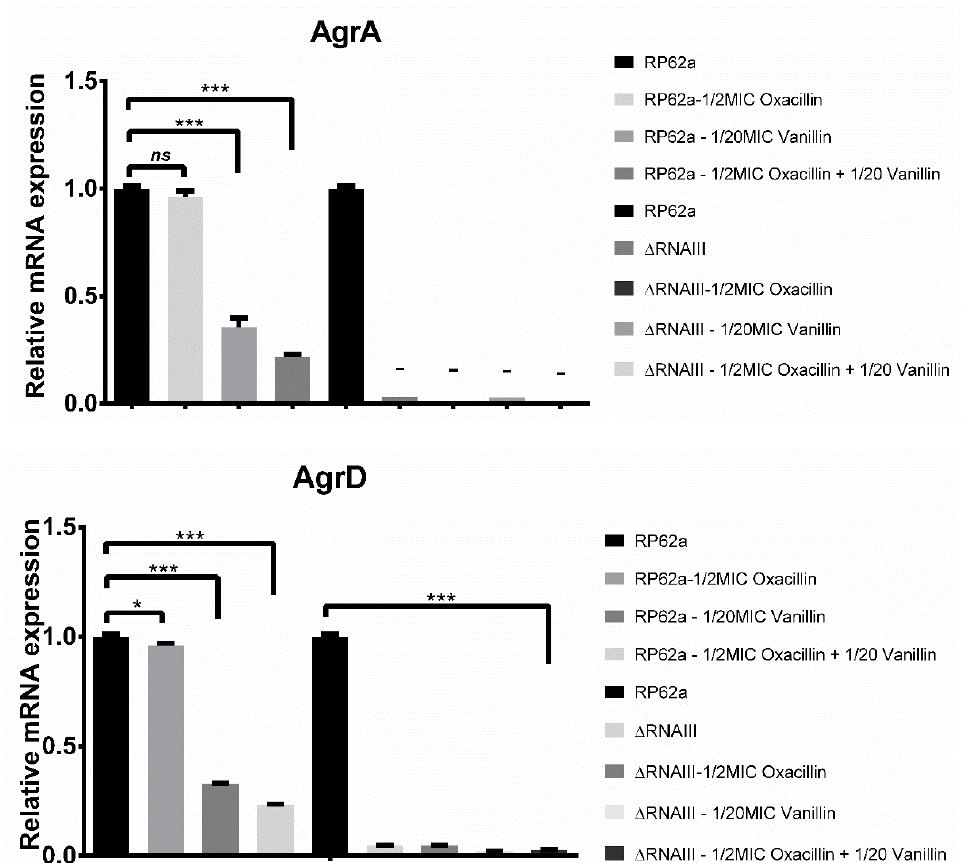
Figure 7. Real-time qPCR analysis of RNAIII-dependent genes agrD and agrA . For both genes, relative mRNA expression was lowered compared to control. As a control, a housekeeping gene for 16S rRNA and unaffected culture were used (ns—non-significant, * p < 0.01, *** p <